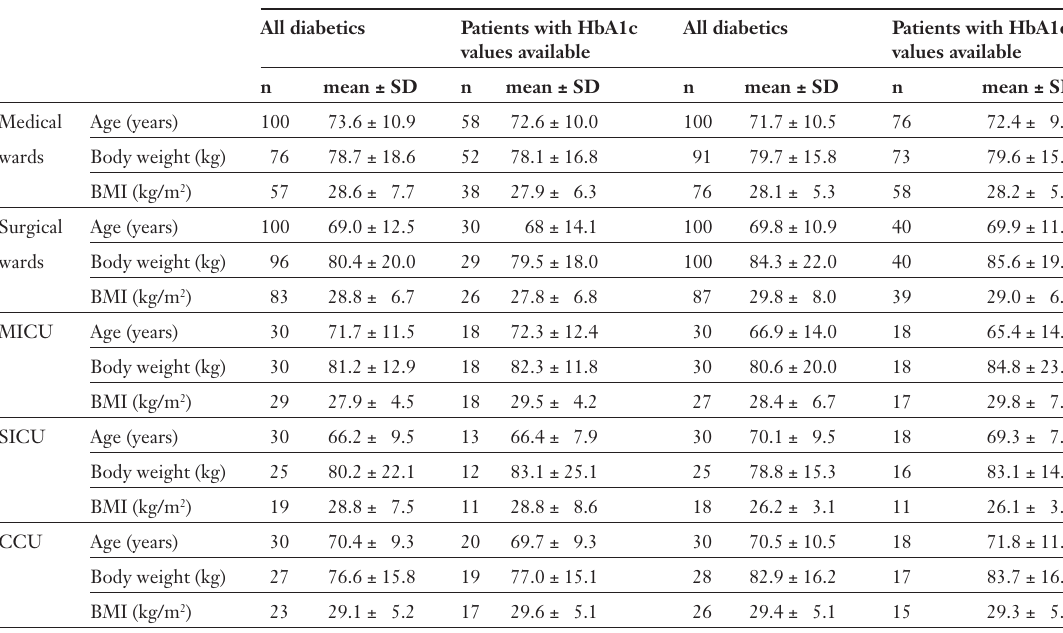
Characteristics of hospitalised patients with diabetes in 2002 and in 2005.